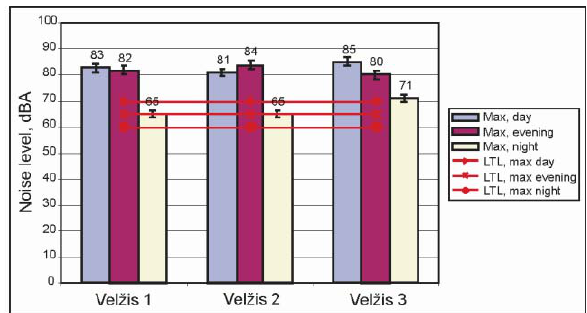
Fig. 3. Dynamics of maximum noise levels in Velţis street